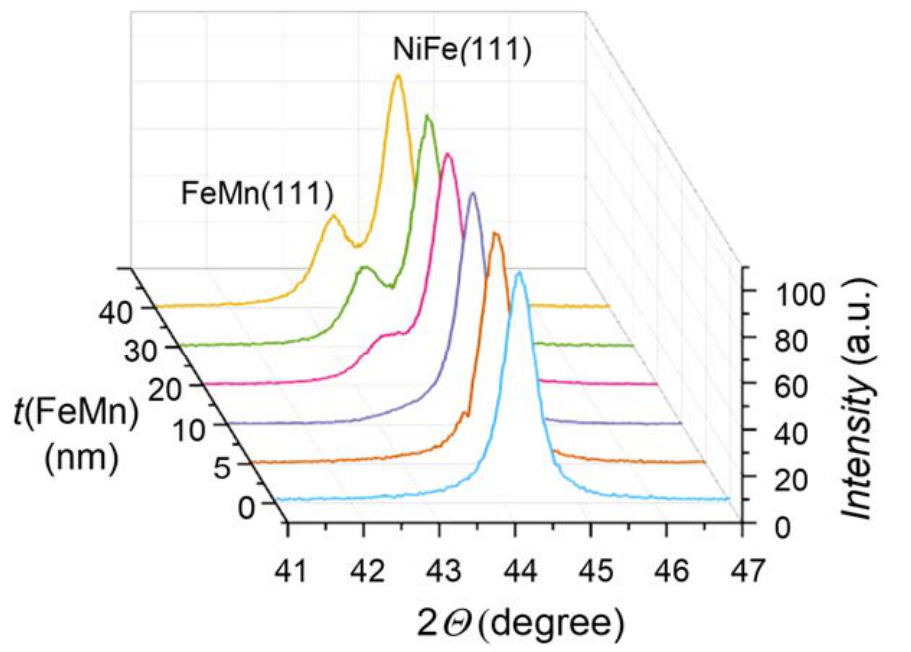
Figure 7. XRD patterns of NiFe (47 nm)/FeMn (t nm) thin films with various antiferromagnetic layer thickness deposited at room temperature.